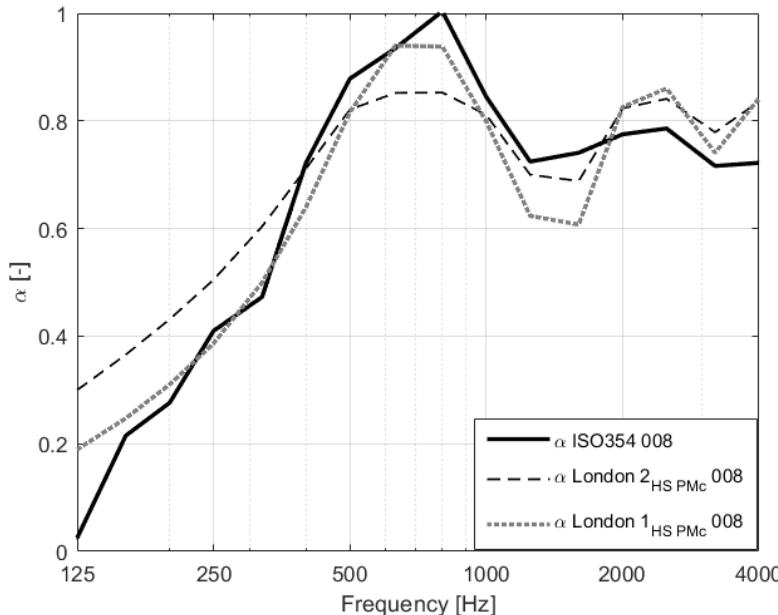
Figure 13. Theoretical and experimental sound absorption curves in diffuse field conditions, in 1/3 octave bands, for both London models.